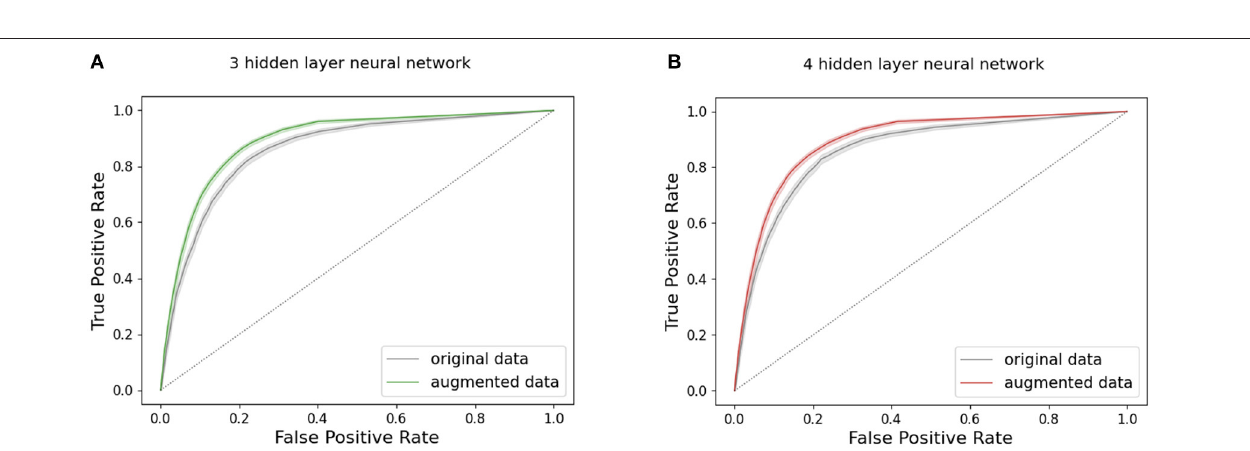
FIGURE 4 | Machine learning model performance: ROC curves with 95% confidence interval for (A) k-nearest neighbors, (B) decision tree, and (C) logistic regression, comparing models trained on augmented and baseline population. True positive rate = TP / ( TP + FN ), false positive rate = FP / ( FP + TN ).